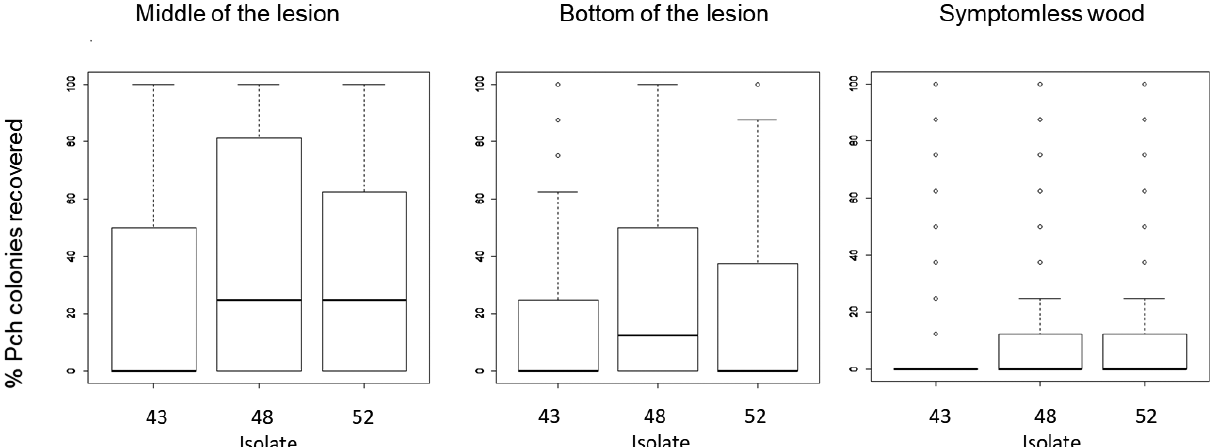
Figure 4. Boxplots of percentage of Phaeomoniella chlamydospora colonies recovered from the middle of lesions, the bottom of the lesions or from symptomless wood, for the three P. chlamydospora isolates. The median is represented by the solid line.